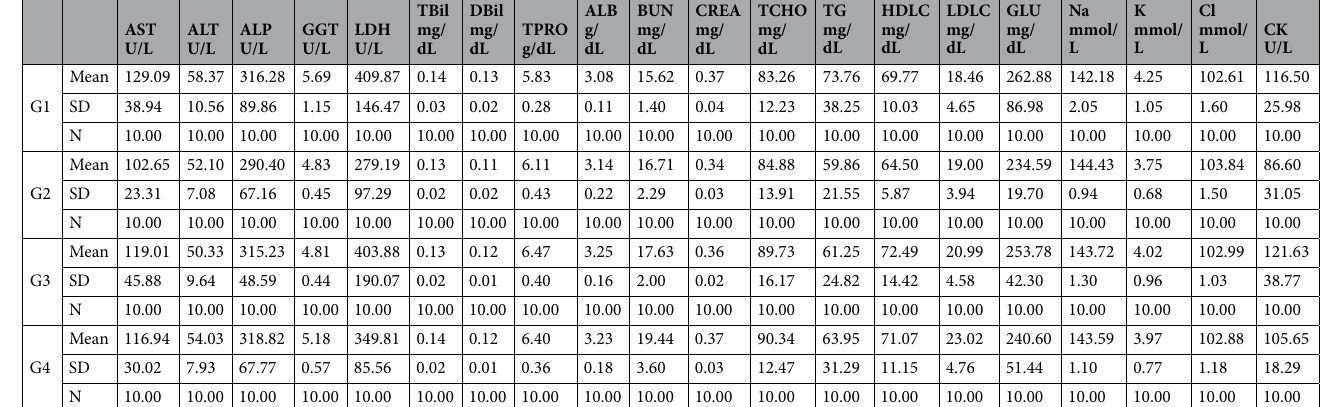
Table 5. Blood biochemical findings at 12 weeks. G: group, SD: standard deviation, N: number, AST: aspartate aminotransferase, ALT: alanine aminotransferase, ALP: alkaline phosphatase, GGT: gamma glutamyl transferase, LDH: lactate dehydrogenase, TBil: total bilirubin, DBil: direct bilirubin, TPRP: total protein, ALB: albumin, BUN: blood urea nitrogen, CREA: creatinine, TCHO: total cholesterol, TG: triglyceride, HDLC: high density lipoprotein, LDLC: low density lipoprotein, GLU: glucose, CK: creatinine